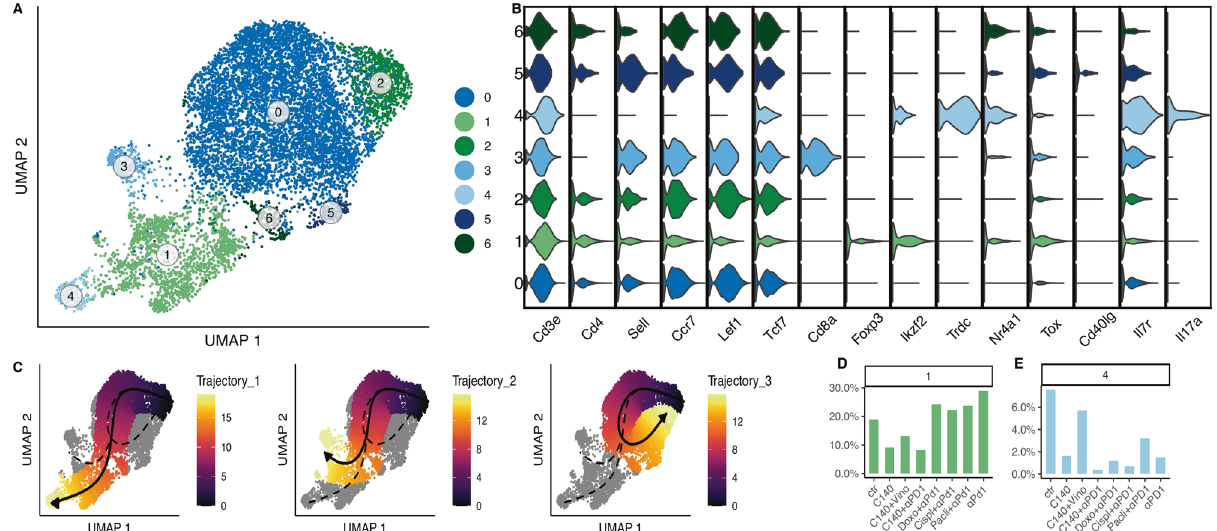
Fig. 2 Cd4-like T cell sub-clustering analysis in 4T1. A UMAP of Cd4-like T cell sub-clustering in 4T1 cell line TMEs. Each dot refers to a cell. The colors refer to the sub-clusters. B Gene signature: the violin plot shows the gene on the x-axis, while the clusters on the y-axis. The colors indicate the corresponding cluster. C Pseudotime trajectory: each dot represents a cell color-coded for pseudotime. D , E Proportions of cells in Cd4 T cell sub-cluster among different conditions. Bar graph shows on the x-axis the conditions, while the percentage of cells per cluster is plotted on the y-axis.